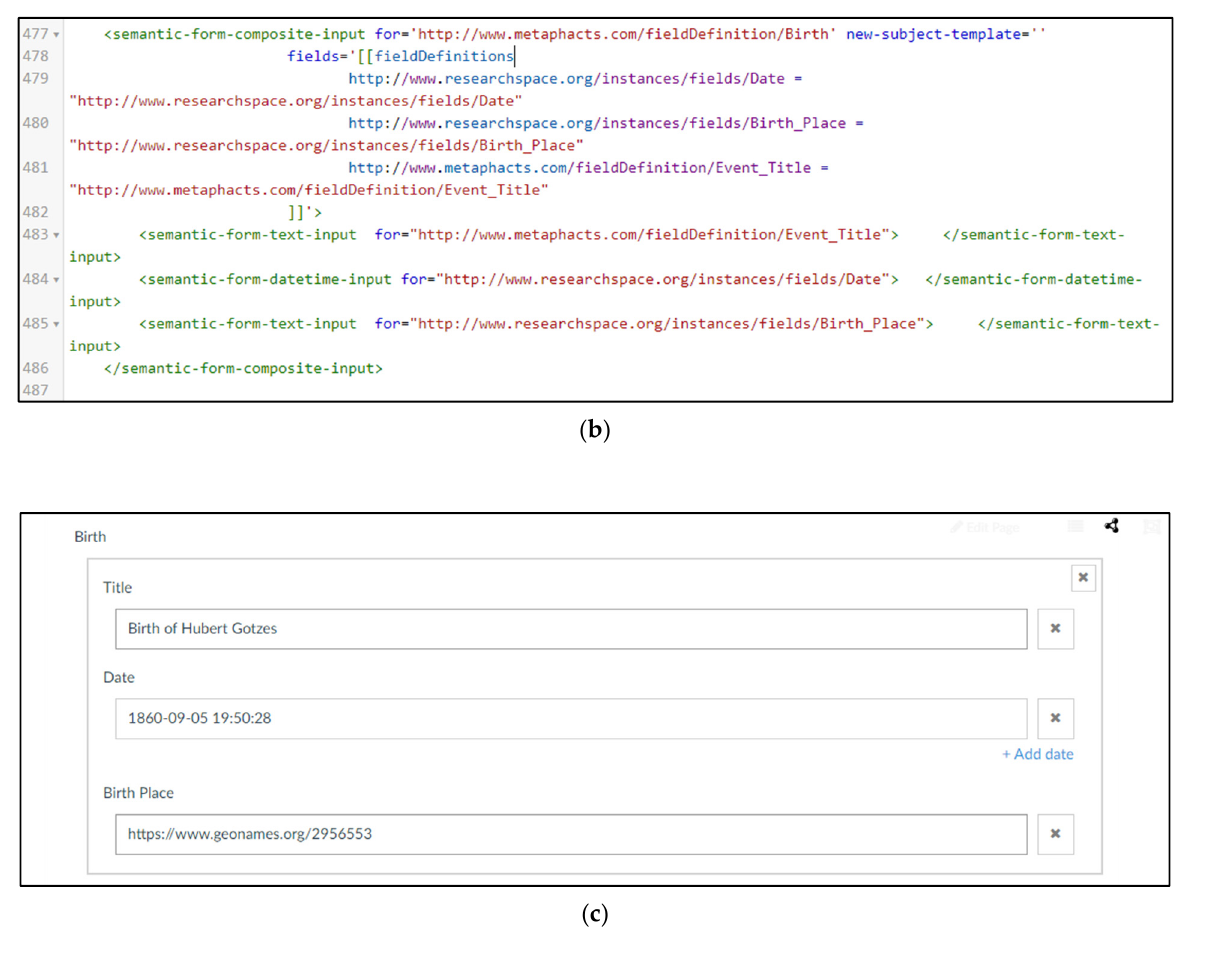
Figure 18. ( a ) Creating a complex field definition, ( b ) Using a complex input field, ( c ) Display a complex field.